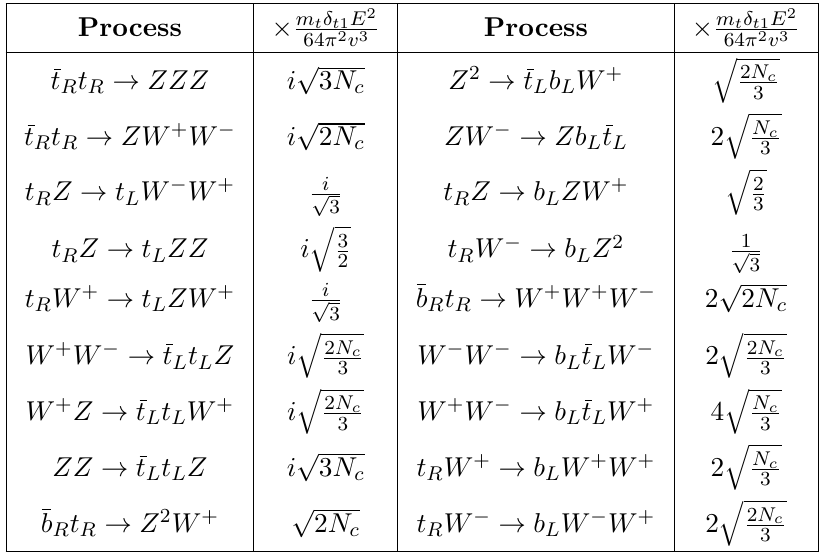
Table 7 . 5-body model-independent unitarity-violating processes from the top sector.